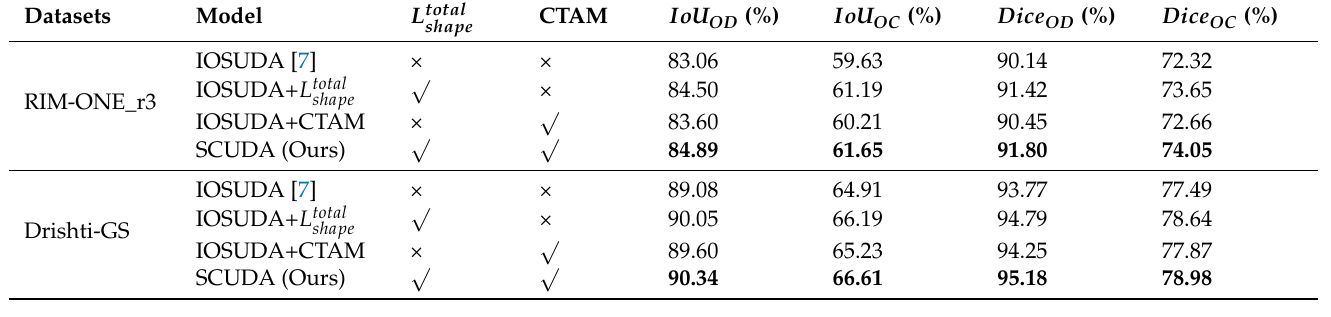
Table 5. AblationstudyontheeffectoftheproposedcomponentsontheRIM-ONE_r3andDrishti-GSdatasets.